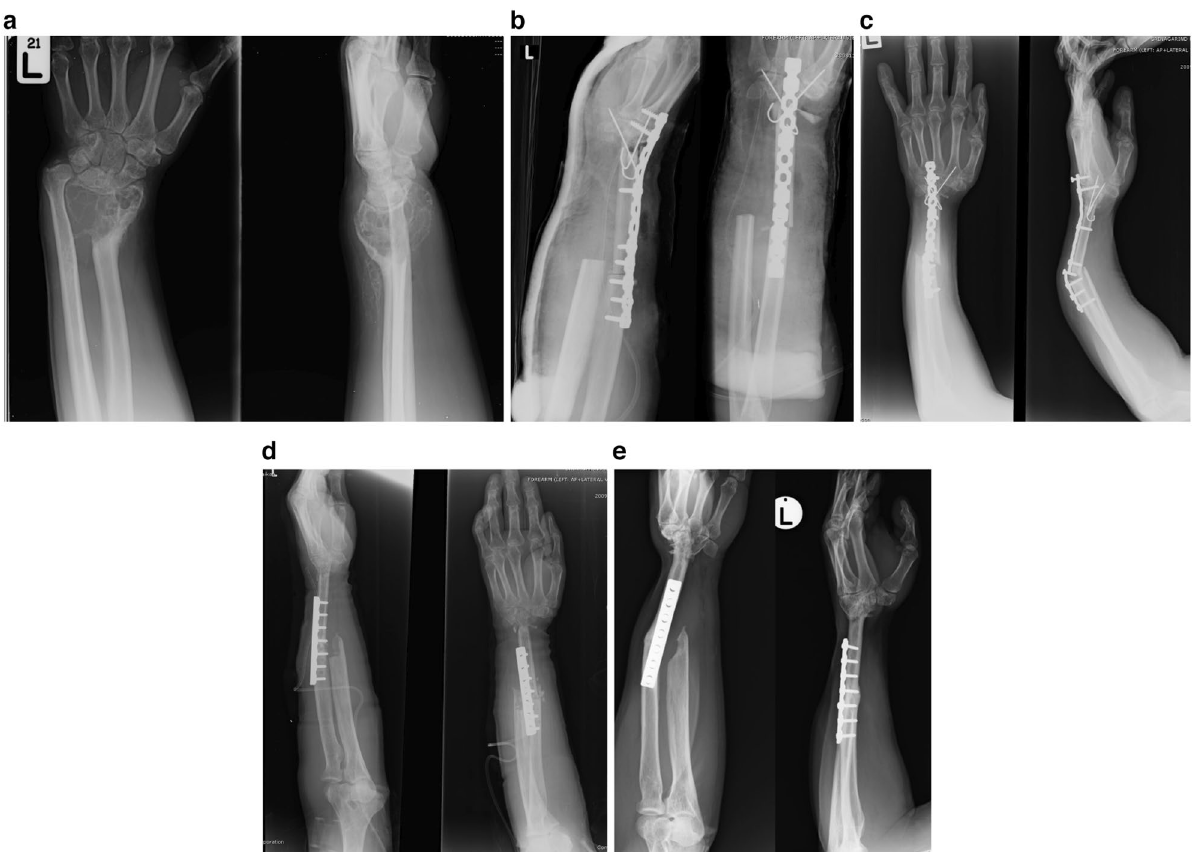
Figure 1. A 47-year-old male with giant cell tumor of the distal radius. ( a ) preoperative anteroposterior and lateral radiograph. ( b ) Postoperative radiograph after wide resection and reconstruction with nonvascularized fibula graft and fusion of the wrist joint. ( c ) Break of plate occurred 13 months postoperatively. ( d ) Revision surgery with plate and screws plus iliac bone graft, bone union was achieved in 9 months. ( e ) Three years after the revision surgery with acceptable functional